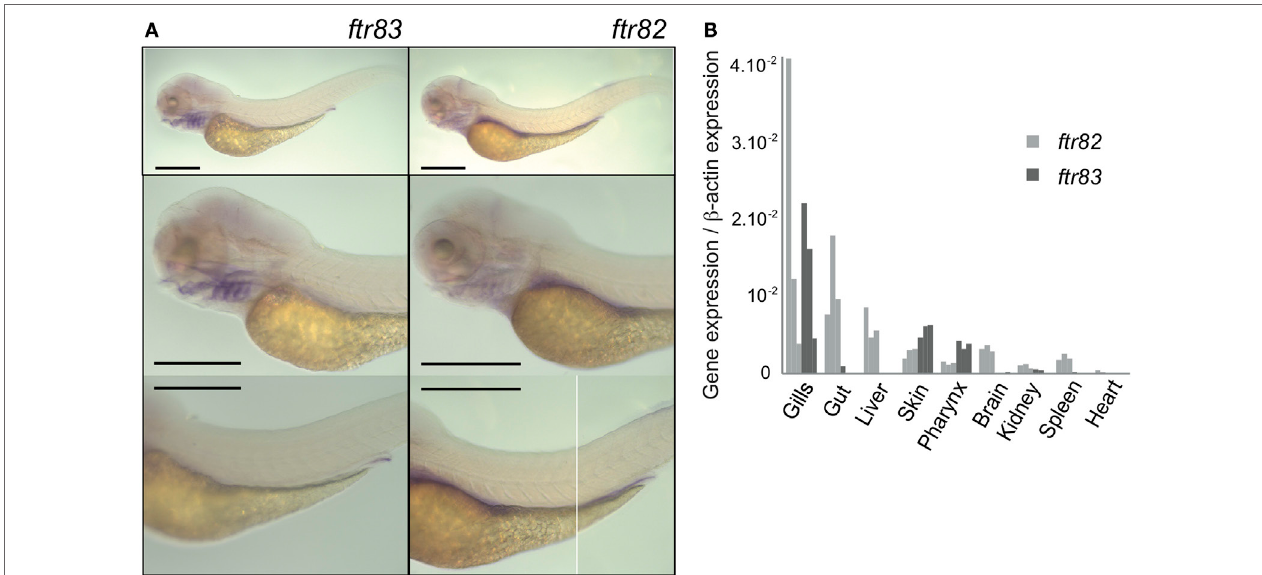
FigUre 2 | ftr82 and ftr83 expression pattern are distinct . (a) Spatial expression of ftr83 and ftr82 in 3.5 dpf zebrafish larvae. WISH using antisense probes indicated on each panel. Scale bars: 0.5 mm. (B) Genes expression in 2–3 months old juvenile zebrafish, measured by RTQPCR in various dissected tissues. Transcript copy numbers were normalized to β -actin expression: measured ratio of cDNA of interest/ β -actin cDNA is shown. Results of three biological replicates, each being a pool of organs from 15